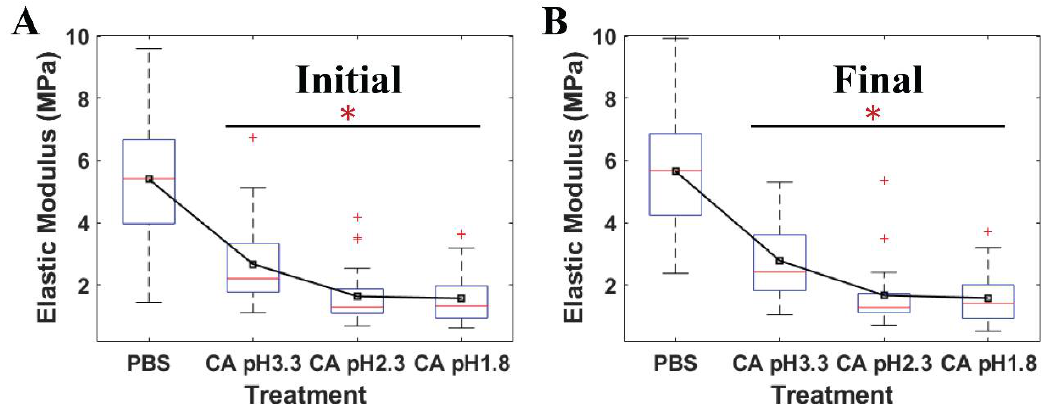
Figure 5. The quantitative elastic modulus of four individual S. mutans cells measured by AFM at ( A ) the initial stage and ( B ) the final stage under PBS pH 7 ( n = 36), citric acid (CA) pH 3.3 ( n = 30), citric acid 2.3 ( n = 30), and citric acid 1.8 ( n = 30). * Value was statistically significant among the elastic moduli of S. mutans treated in PBS and low pH citric acid environments, p < 0.001. Int. J. Mol. Sci. 2020 , 21 , x FOR PEER REVIEW